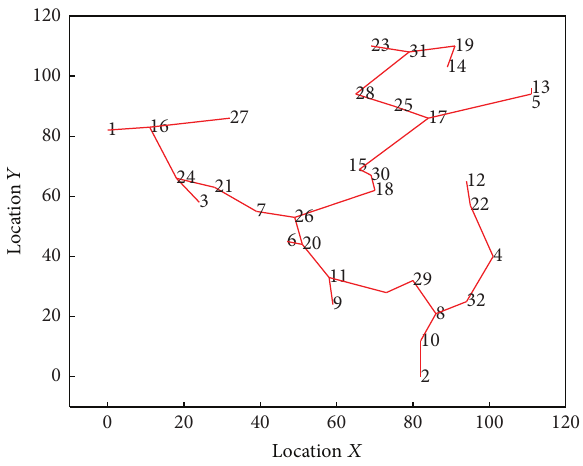
Figure 7: Output of the Prim algorithm.